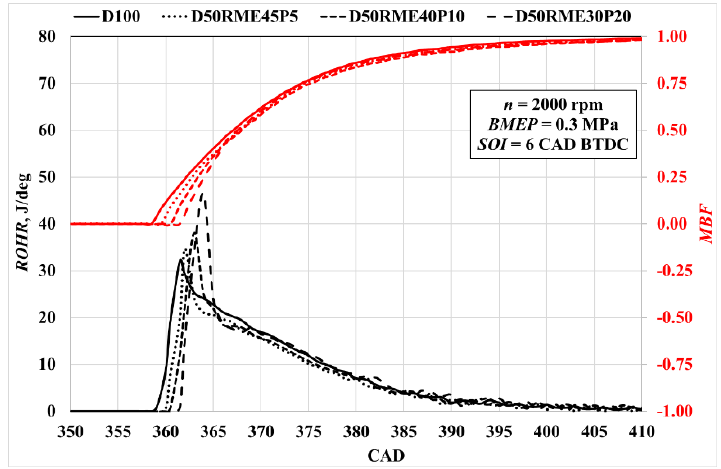
Figure 7. Dependence of the rate of heat release and the mass burnt fraction on the crank angle degree.